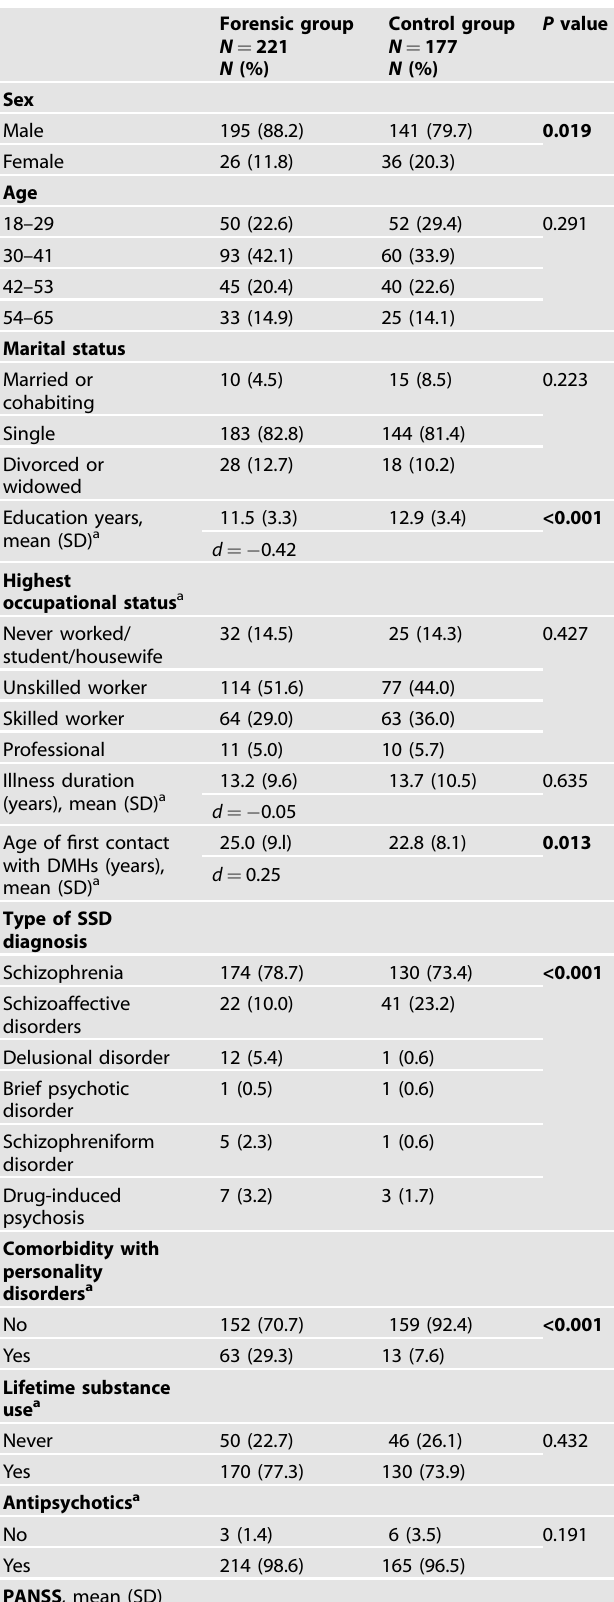
Table 1. Socio-demographic and clinical characteristics of forensic patients with SSD and